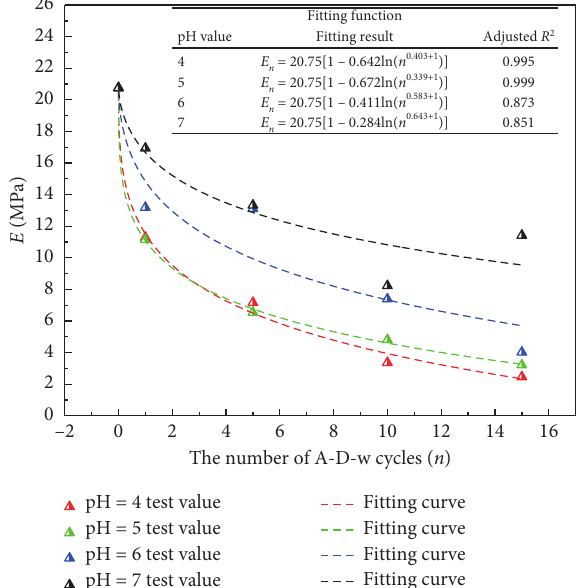
Figure 18: Relation of damage model value σ with n .